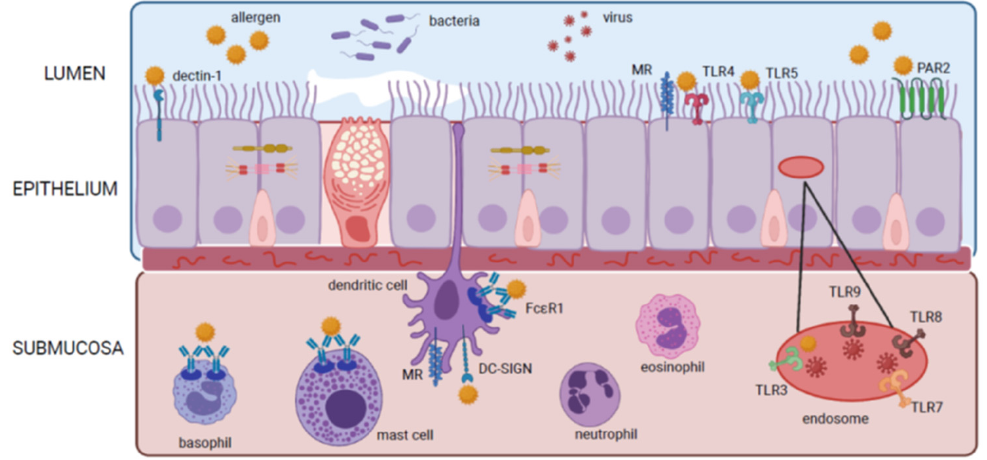
Figure 1. Mechanisms of alarmin cytokine release from epithelium and leukocytes in the airway. TLRs, RLRs, and NLRs all recognize different but overlapping microbial components; however, only TLRs have been proven to respond to environmental allergen